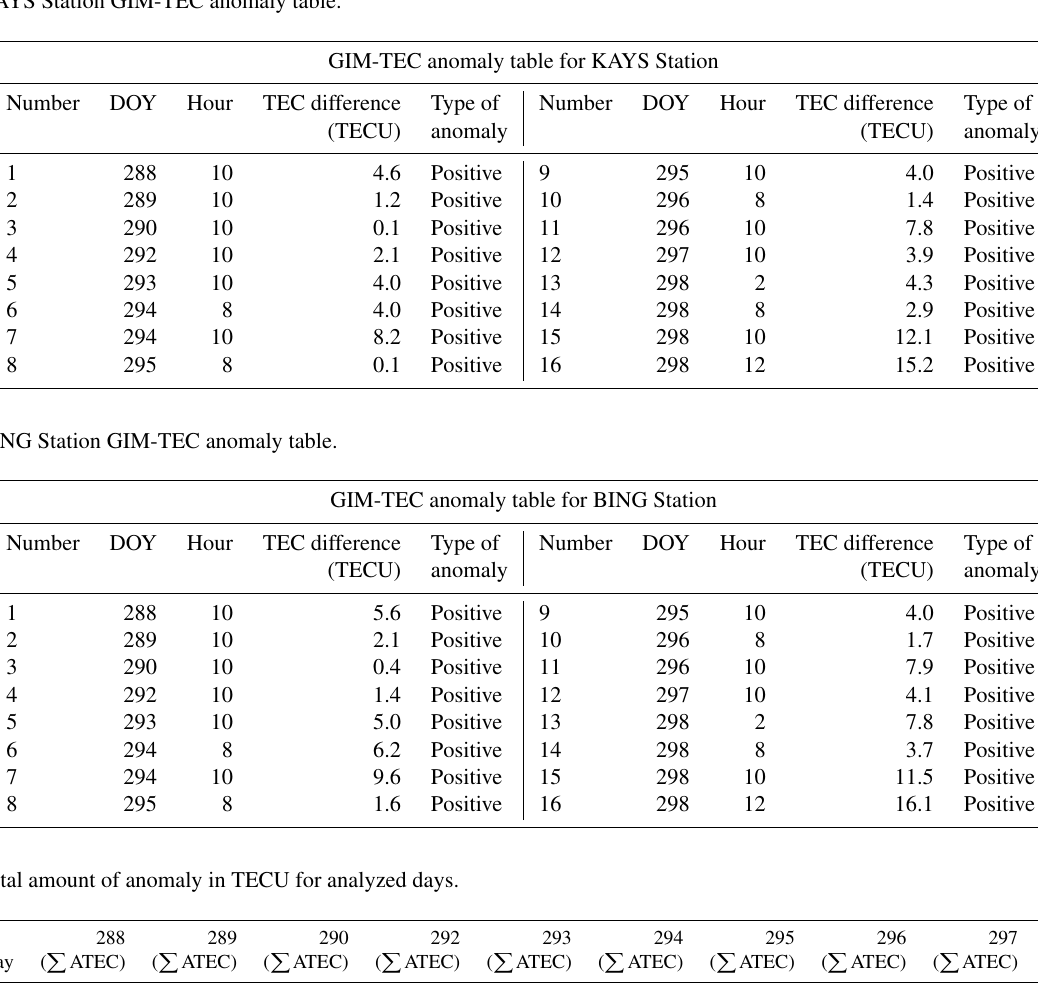
Table 5. KAYS Station GIM-TEC anomaly table.